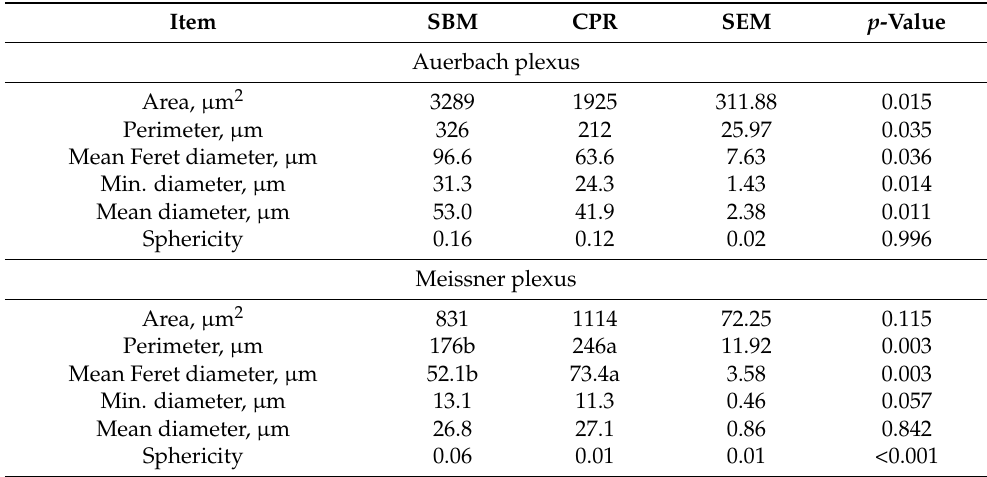
Table 5. Effect of raw chickpea on histomorphometric parameters of nerve plexuses in the jejunum in 42-day-old broiler chickens 1